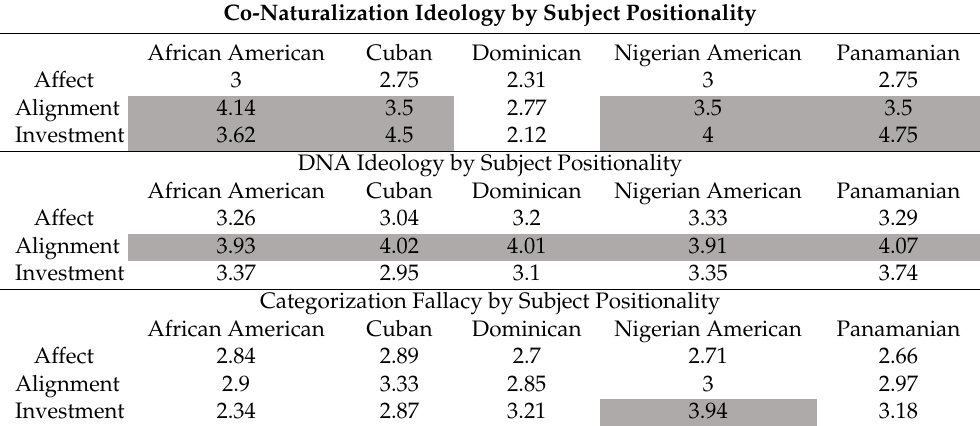
Table 6. Raciolinguistic ideology by subject